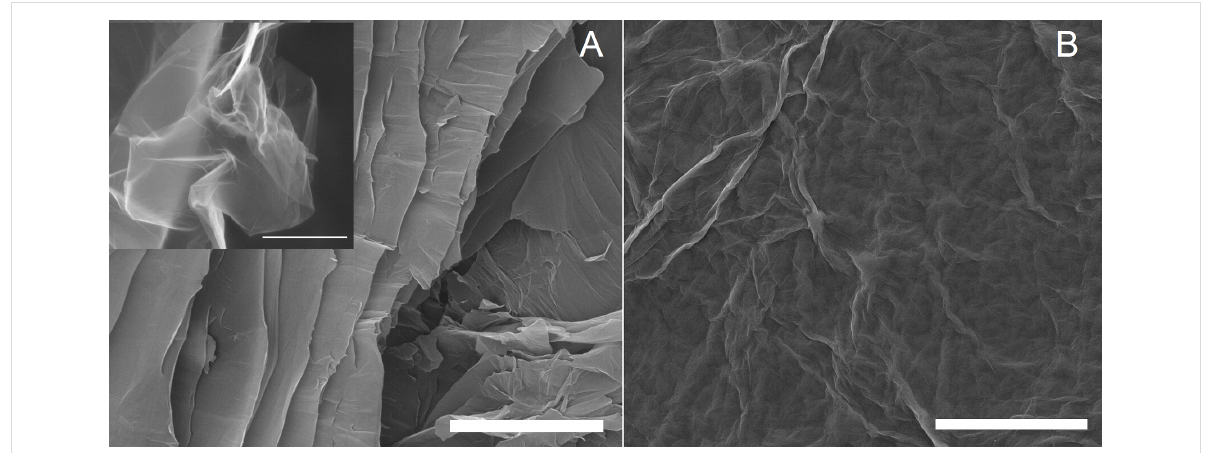
Figure 2: SEM images of A) GO and B) GO-P. The inset in Figure 2A shows a crinkled GO flake. Scale bar: 5 μ m.